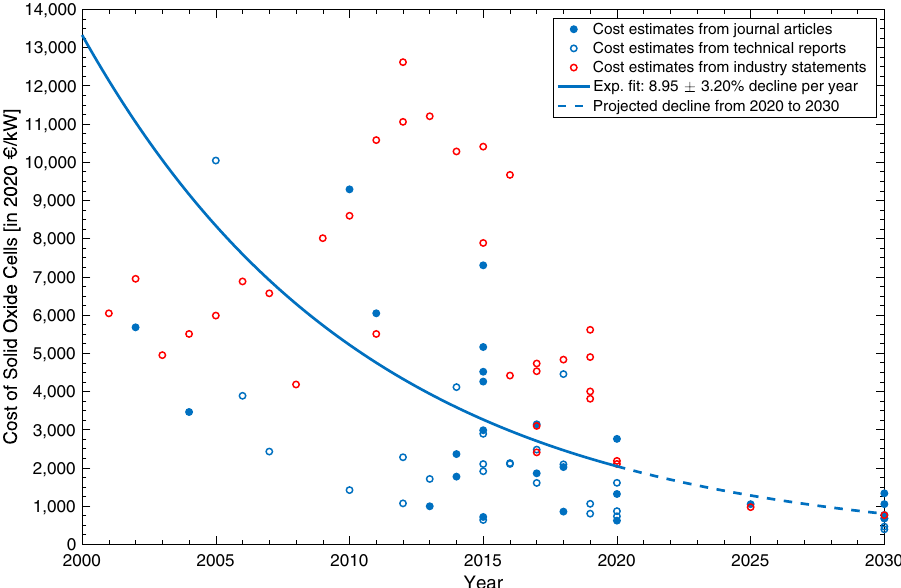
Fig. 3 Cost of solid oxide cells. Cost data comes from multiple sources. The univariate regression suggests a constant cost decline over the coming years. The fairly large variance in system prices illustrates the relative novelty of the technology.